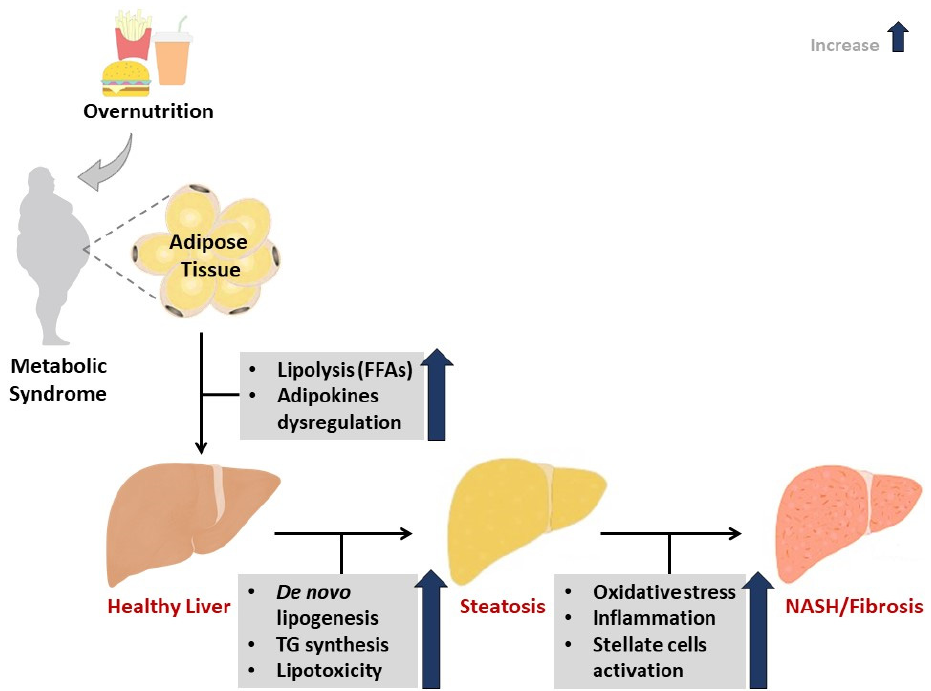
Figure 1. An overview of pathophysiological mechanisms that link metabolic syndrome and the development of non-alcoholic fatty liver disease (NAFLD). Briefly, impaired adipose tissue function and insulin resistance remain instrumental in promoting hepatic lipid accumulation in conditions of metabolic syndrome. In such cases, enhanced lipolysis, together with impaired adipokine function can contribute to the development of oxidative stress and an abnormal inflammatory response. The degree of oxidative stress and inflammation can define the deterioration of NAFLD, even leading to the liver steatosis and non-alcoholic steatohepatitis (NASH). TG = triglycerides, FFAs = free fatty acids.